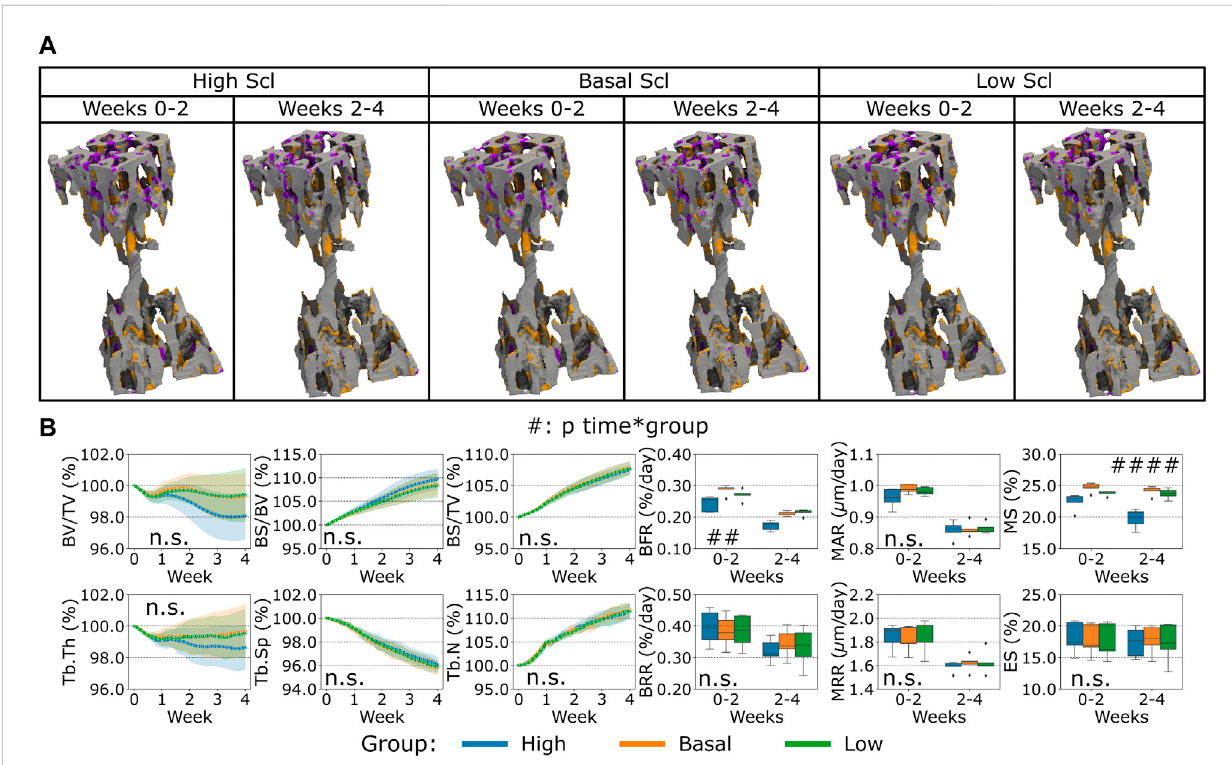
FIGURE 6 In silico results of variations of the maximum single cell production level of sclerostin (Scl) by osteocytes. (A) Biweekly FQR regions of results obtained with higher and lower Scl productions levels for the representative mouse (number 5). Bone formation in orange, quiescence in gray, and resorptioninpurple. (B) Staticanddynamicbonemorphometryparametersoftheresultsofthesimulationsofthesamegroupofmice( n =5)underthree different production levels of Scl, starting from the same initial condition of the basal level. High = higher production level of Scl, Basal =